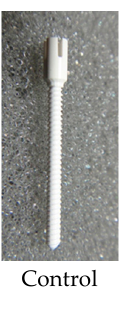
Figure 10. The control and alkali-treated NANOZR implant photographs.